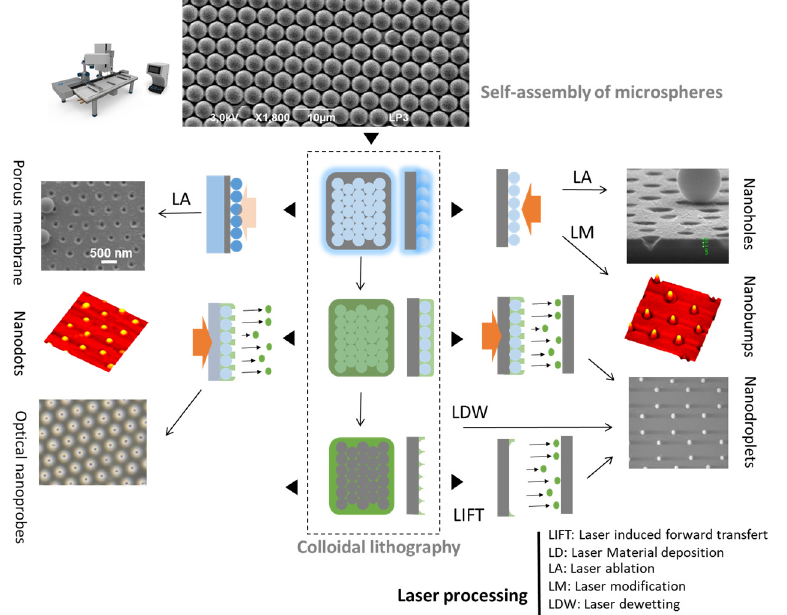
Figure 7. Nanofabrication by microsphere-laser joint methods. Most of the technologies in the panel of laser processing methods, that are additive, subtractive or corrective, can benefit from the focusing power of microspheres for large-scale synthesis of periodic structures at submicron scales. Inserted final structure images are extracted from references, all mentioned in the text.